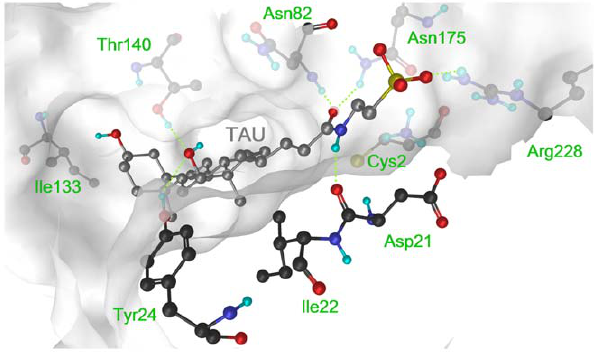
Figure 4. CBAH in its Michaelis complex with TAU. CBAH carbon atoms are in black, while TAU carbon atoms are in gray. The CBAH active site is represented as a solid van der Waals surface (white), which is occupied by TAU substrate. Relevant CBAH residues are displayed and labeled. Relevant H-bonds between the substrate and CBAH are shown as dotted green